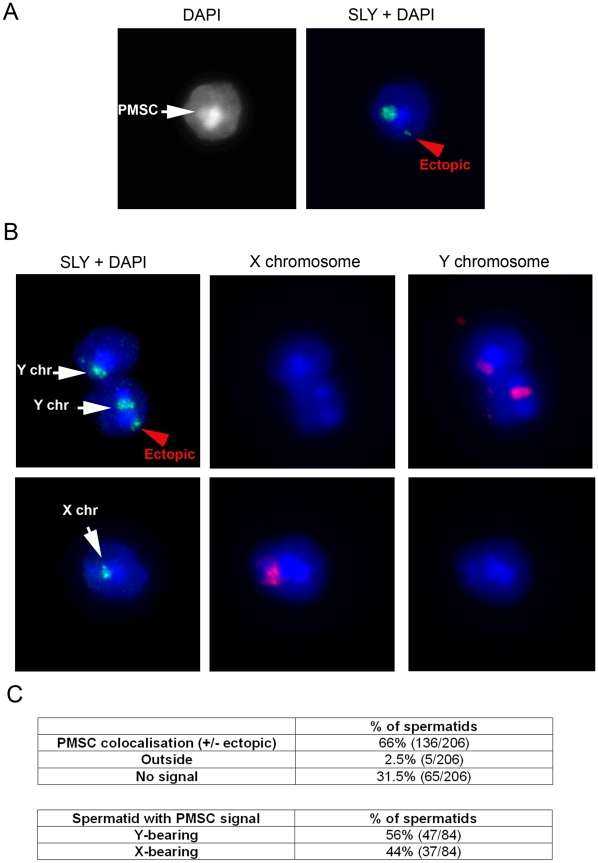
SLY protein colocalizes with the sex chromatin in round spermatids.(A) and (B) Detection of SLY protein (green) by immunofluorescence in surface-spread spermatids. DAPI (white or blue) was used to stain nuclei. SLY protein colocalizes with the PMSC (white arrow) in round spermatids. A fainter signal is sometimes observed outside PMSC (ectopic, red arrowhead). X and Y chromosome painting shows that SLY colocalizes with either sex chromosome in spermatids. See Figure S10 for controls. (C) The tables indicate the percentage of spermatids with SLY PMSC staining, and the percentage of X-bearing or Y-bearing spermatids with SLY PMSC staining.